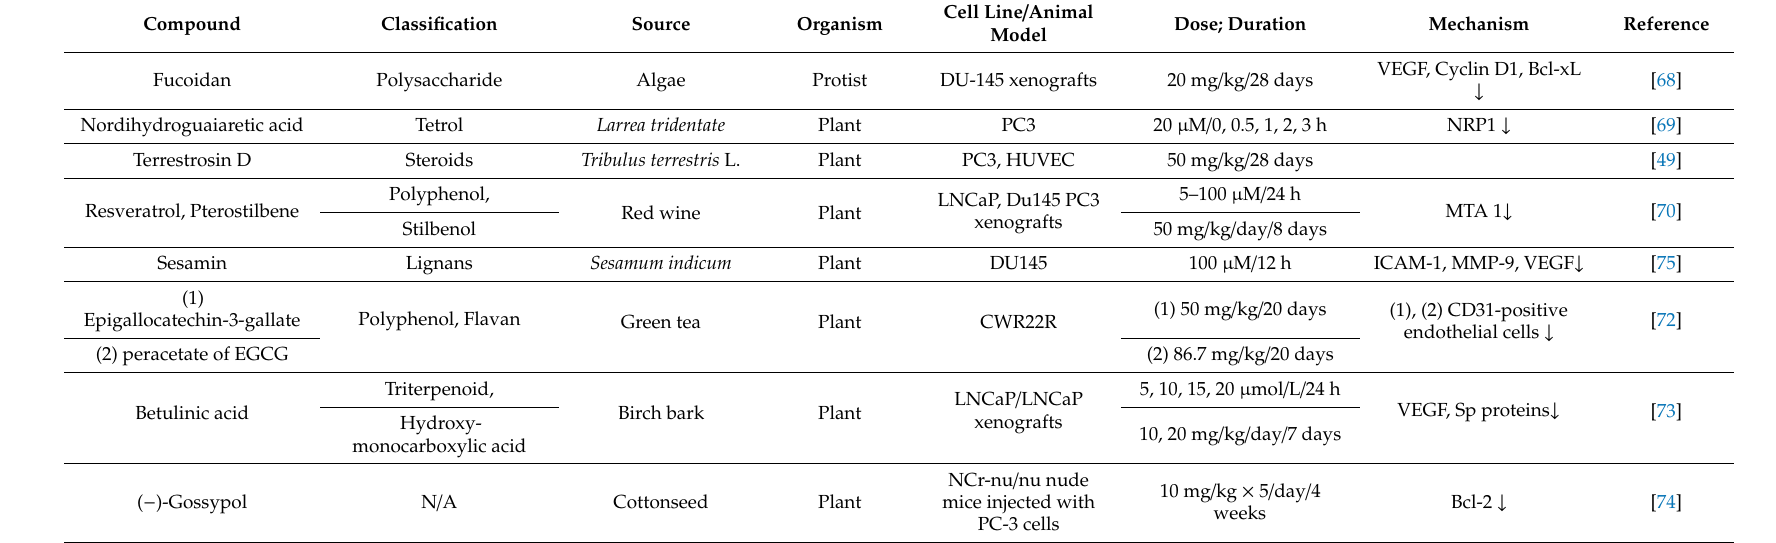
Table 5. Anti-angiogenesis inducing dietary